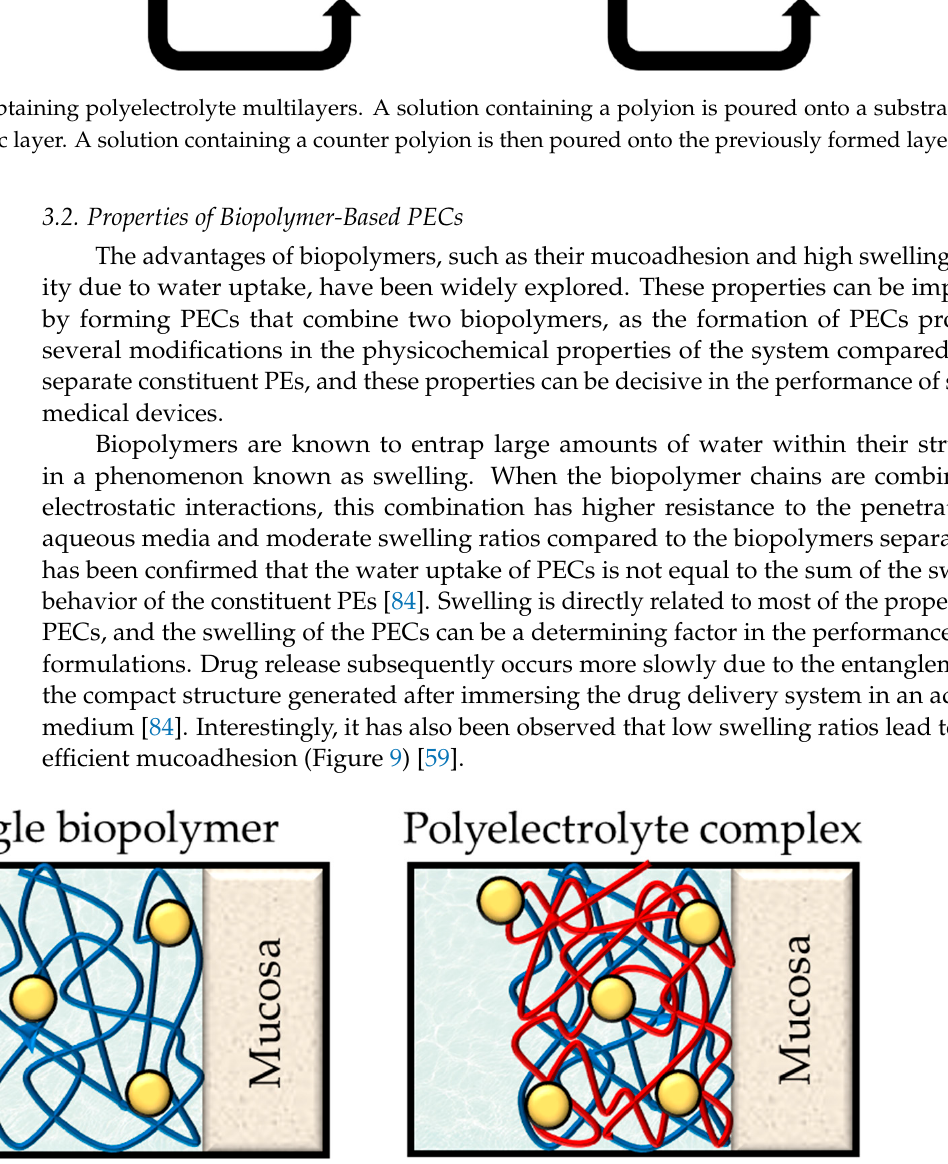
Figure 9. Swollen drug delivery systems based on a single biopolymer and on a polyelectrolyte complex. After the polymer swells, the medium is interposed between the polymer chains. The strong interaction between the polyelectrolytes prevents the separation of the polymer chains, and the high cross-linking between the chains means a greater capacity to control drug release and adhere to mucosa.